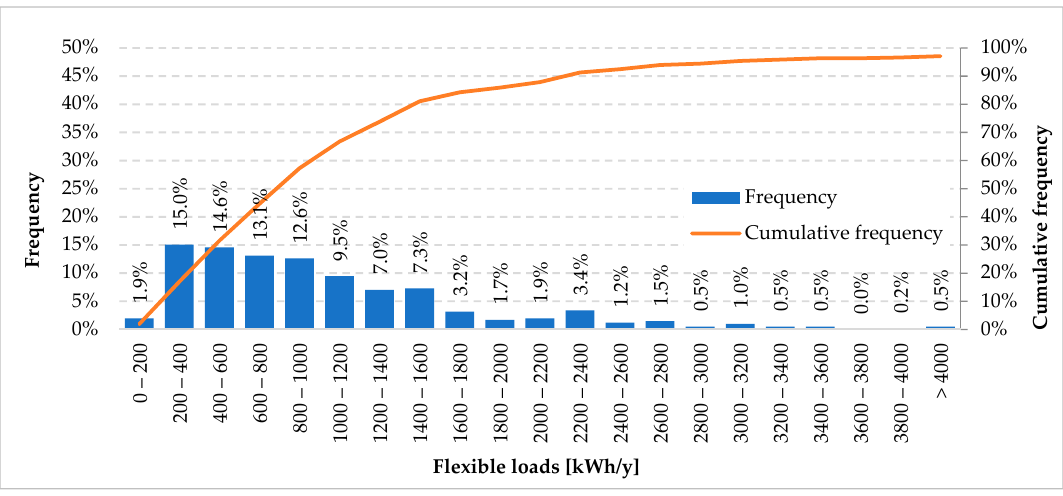
Figure 12. Flexible loads.